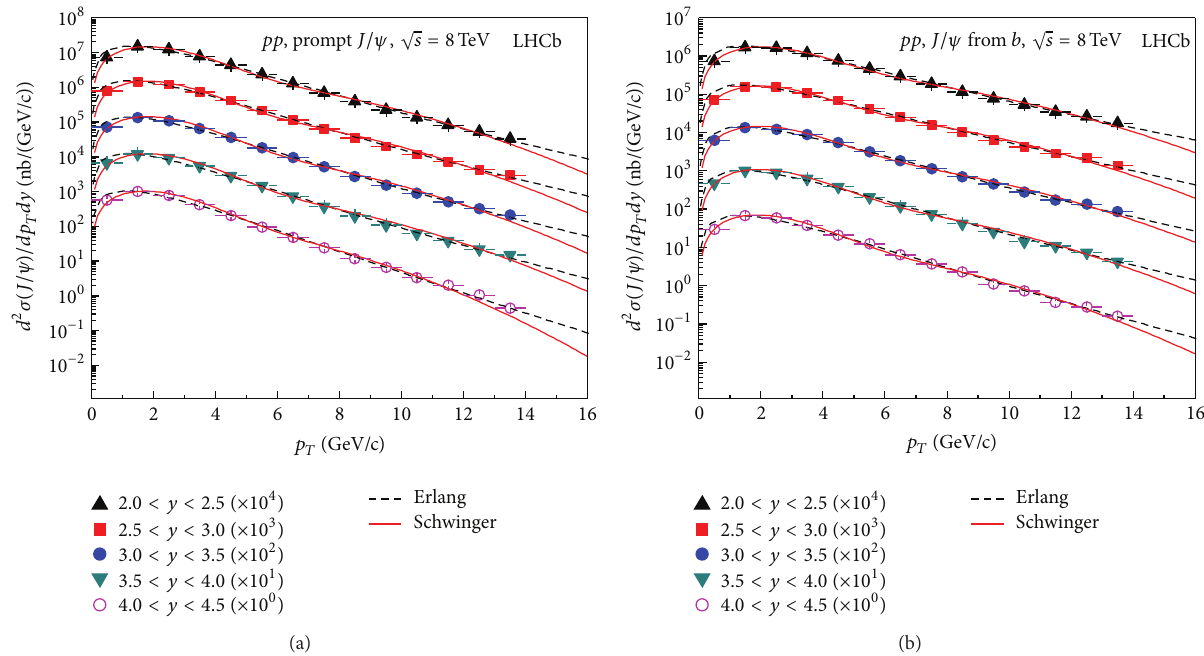
Figure 2: Transverse momentum spectra of (a) prompt 𝐽/𝜓 and (b) 𝐽/𝜓 from 𝑏 in 𝑝𝑝 collision at √𝑠 = 8 TeV. The symbols represent the experimental data of the LHCb Collaboration [18]. The dashed and solid curves are our results calculated by using the two-component Erlang distribution and the two-component Schwinger mechanism,